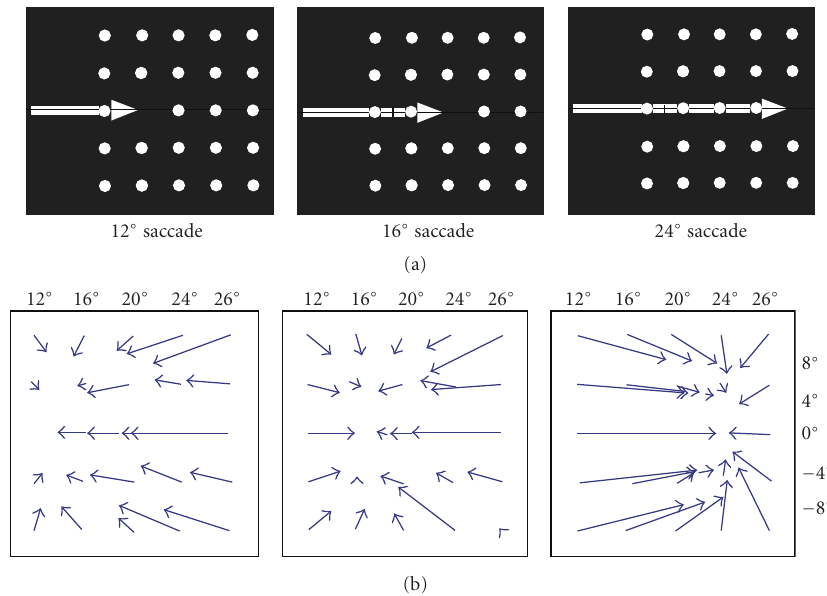
Figure 5: Experimental data (see [20]) of the absolute mislocalization (lower row) referenced to the true position of a flashed dot randomly chosen from an array of 24 dots and three di ff erent saccade amplitudes (upper row) are shown.